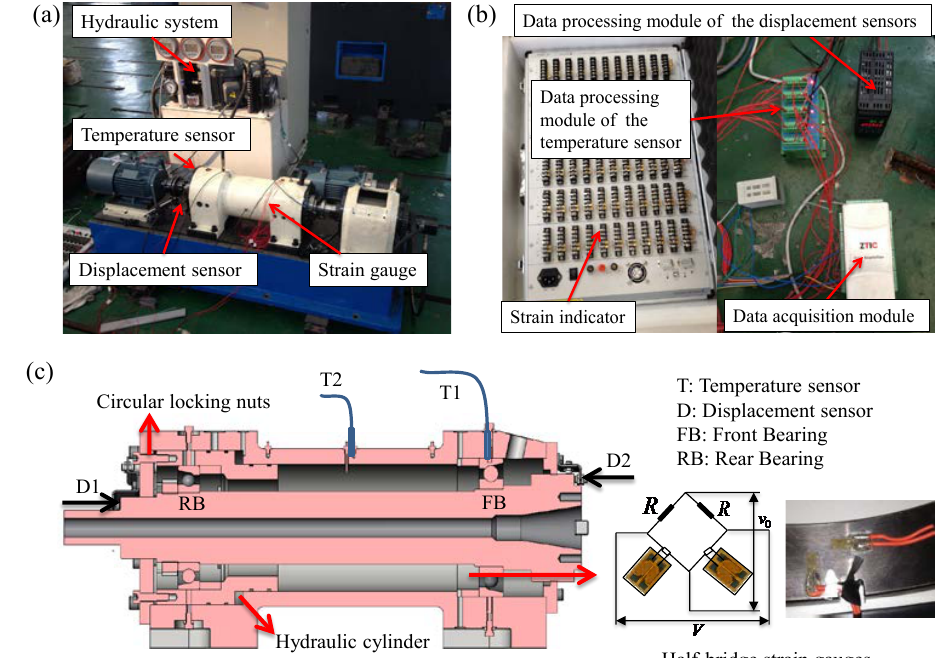
Figure 8. Test rig of spindle-bearing system. (a) Overall view. (b) Measurement system. (c)